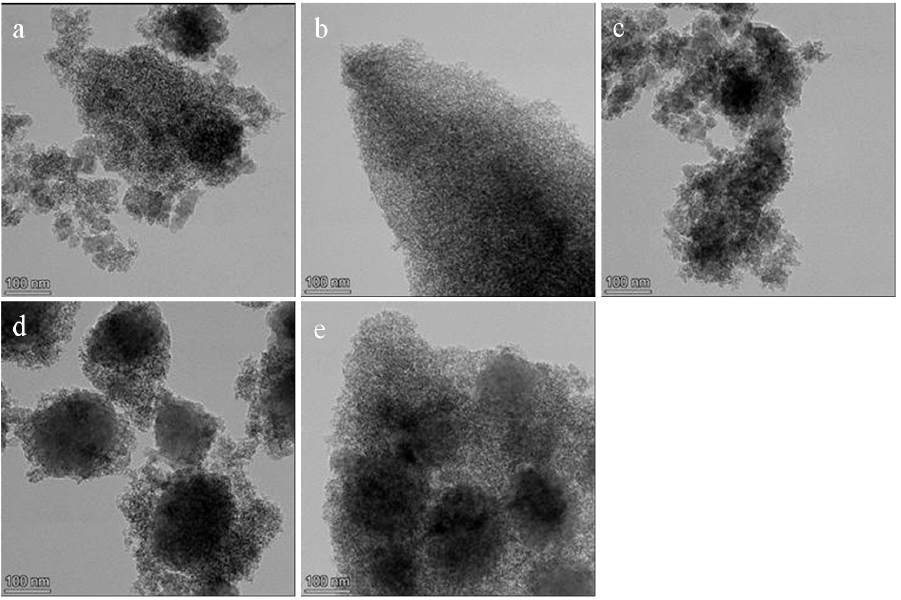
Figure 4. TEM images of ( a ) NM-ZSM-5-0 h, ( b ) NM-ZSM-5-4 h, ( c ) NM-ZSM-5-8 h, ( d ) NM-ZSM-5-16 h, and ( e ) NM-ZSM-5-24 h.